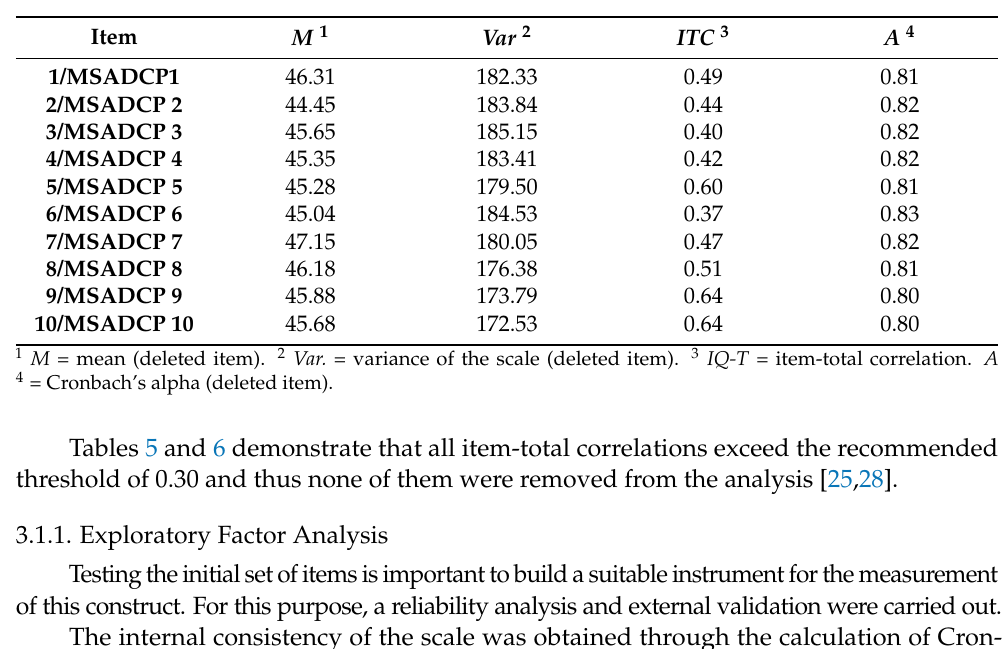
Table 6. Internal consistency of the Satisfaction